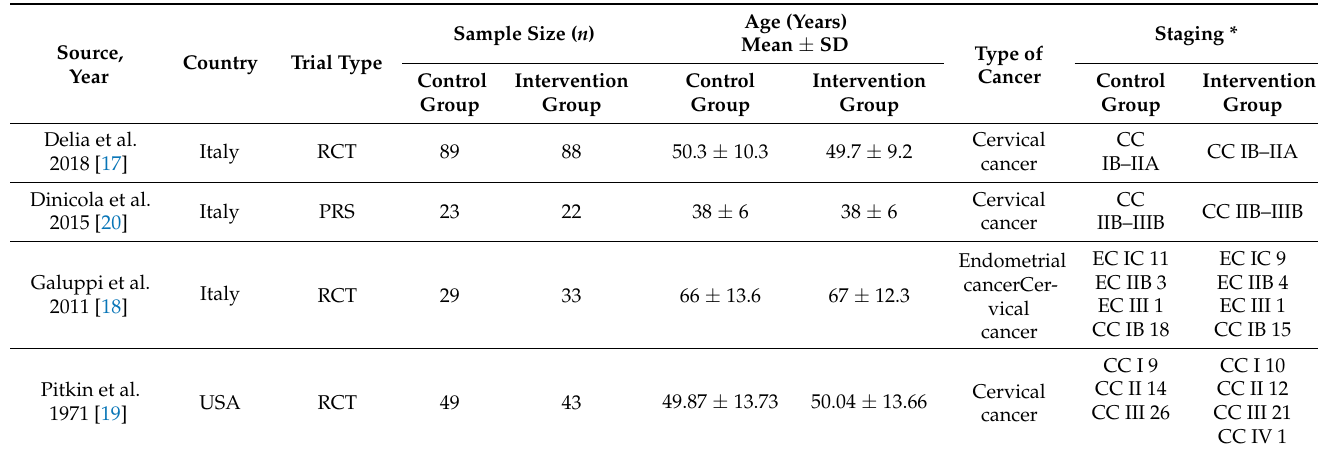
Table 1. Characteristics of enrolled population ( n = 376).